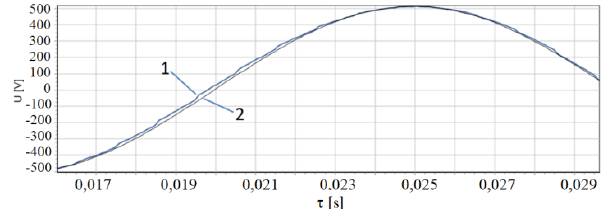
Fig. 1. The chart of line voltage synchronous generator as a function of time: 1 – waveform measurements obtained from 2 – course model